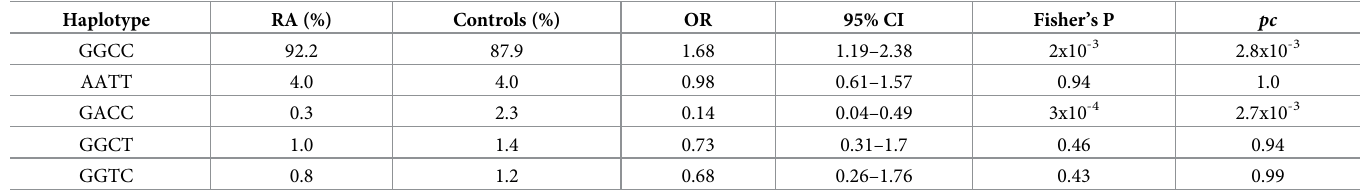
OR = odds ratio. CI, confidence interval. pc : corrected p -value after 100,000